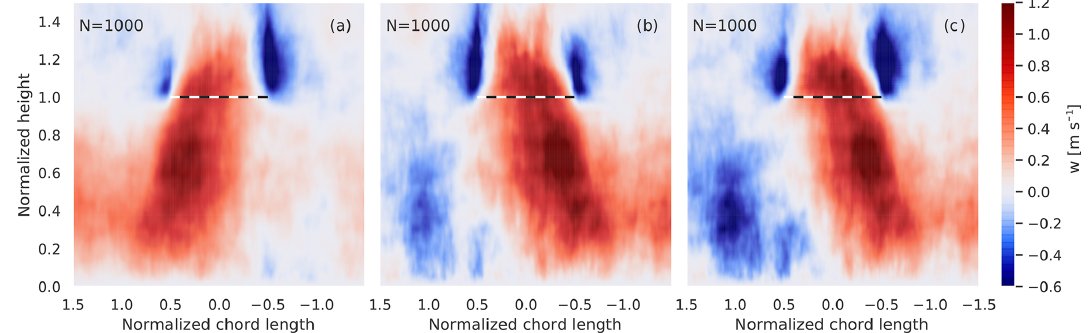
Figure 4. Mean vertical velocity scene of 500 chords in the x direction and 500 chords in the y direction from a 3D snapshot of the MicroHH simulation on 11 June 2016. The black dashed and white line marks the chord-base height. Shown are scenes that result from not taking the wind direction into account (a) , weighting the x and y scenes using the wind speed at chord-base height before merging (b) , and weighting the x and y scenes differently at each height using the vertical profile of horizontal wind (c) . See Sect. 3.2 for a detailed description of how scenes are derived from 3D snapshots as illustrated in Fig.